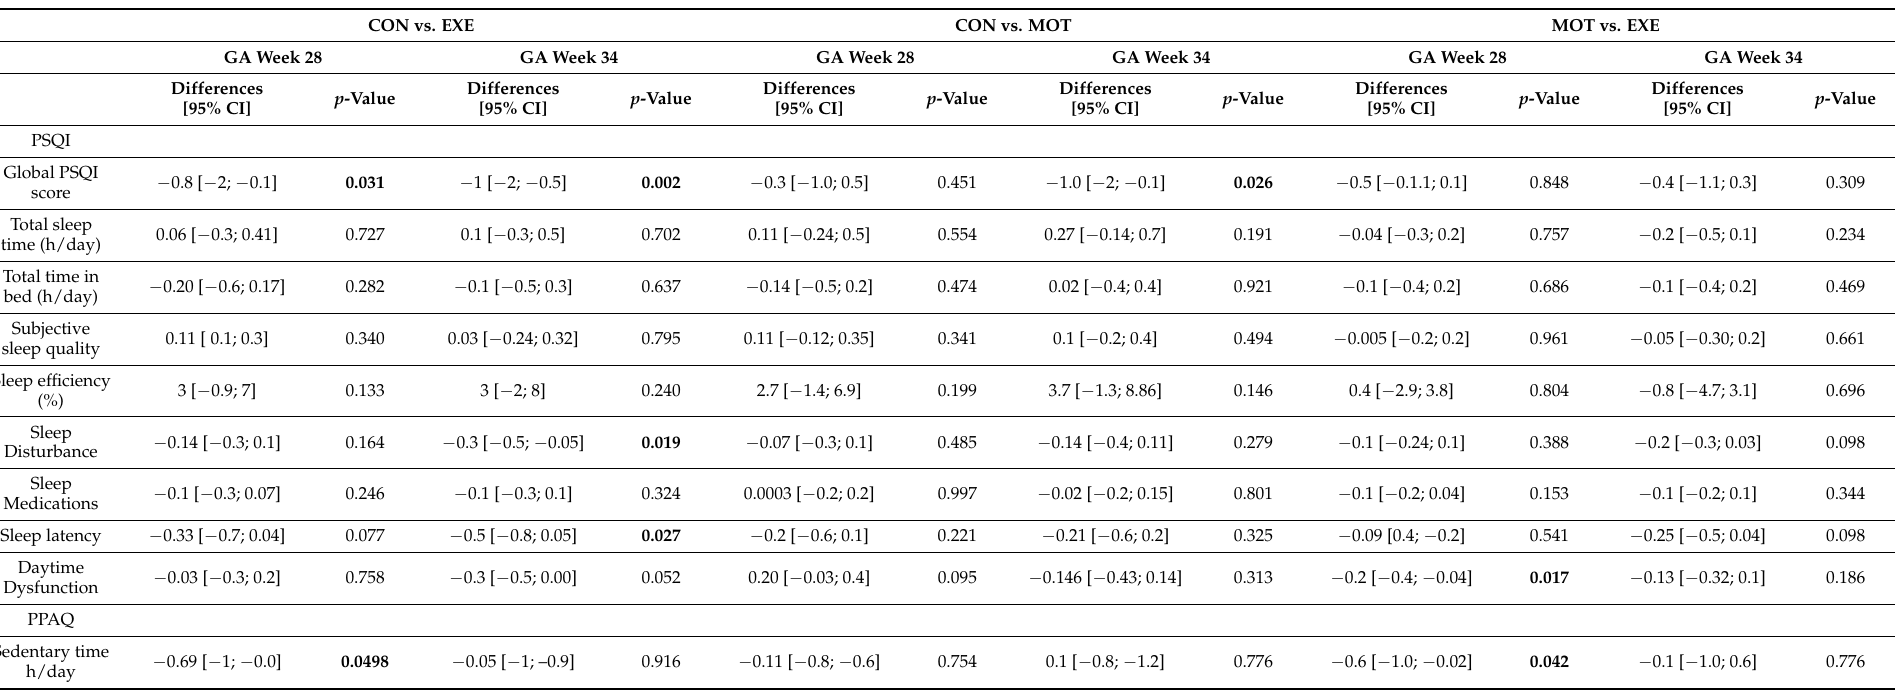
Table 1. Outcomes from the Pittsburgh Sleep Quality Index and sedentary time from the Pregnancy Physical Activity Questionnaire. CON vs. EXE CON vs. MOT MOT vs. EXE GA Week 28 GA Week 34 GA Week 28 GA Week 34 GA Week 28 GA Week